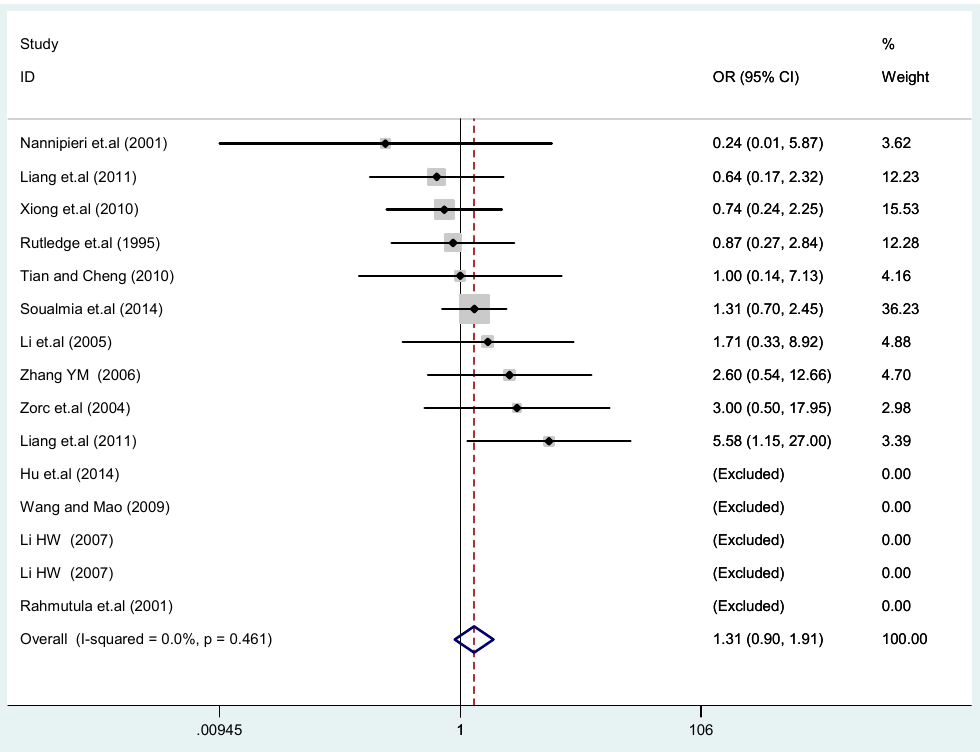
Figure 4. Forest plot of overall population of T2238C co-dominant model-2 (CC vs. TT).